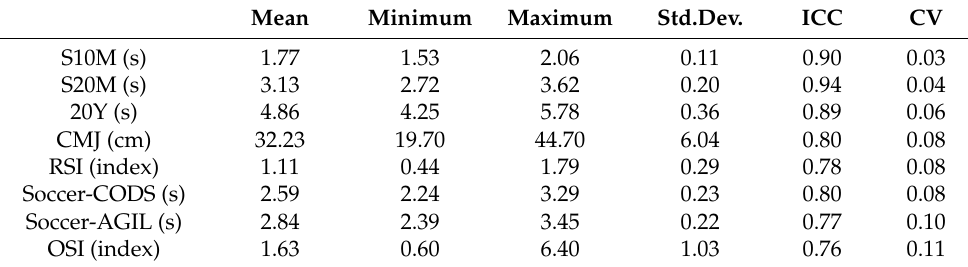
Table 1. Descriptive statistics and intra-testing reliability (ICC, CV) for the fitness tests and motor performance tests.